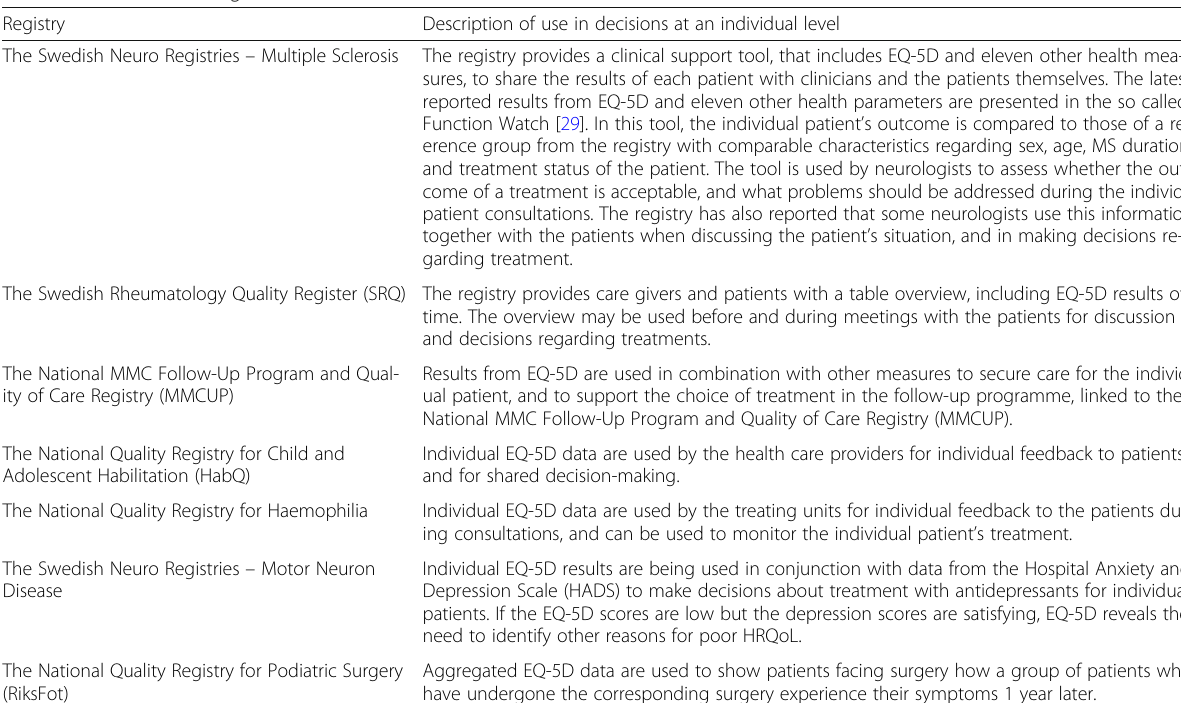
Table 5 Use of EQ-5D results during individual patient consultations (with the purpose of screening, monitoring, decision aids and/ or shared